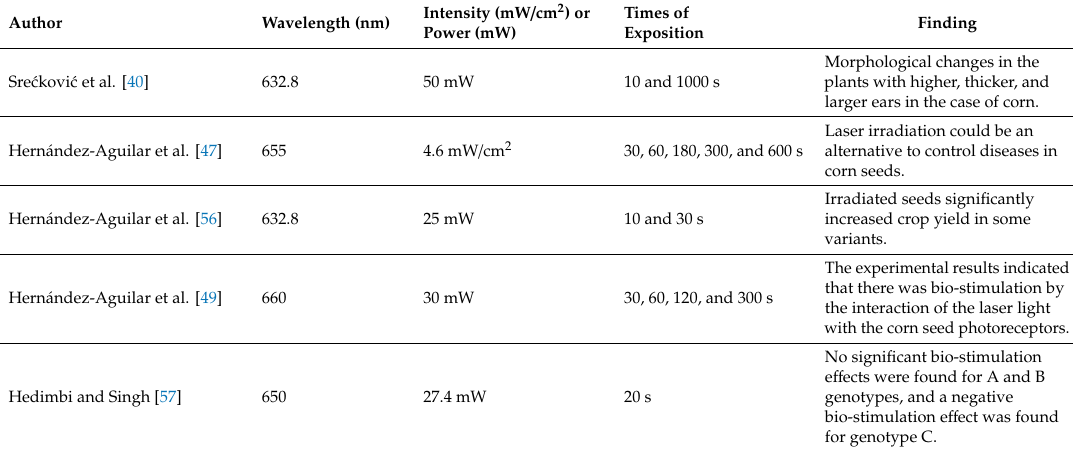
Table 3. Presenting the bio-e ff ects of low-intensity laser light in maize